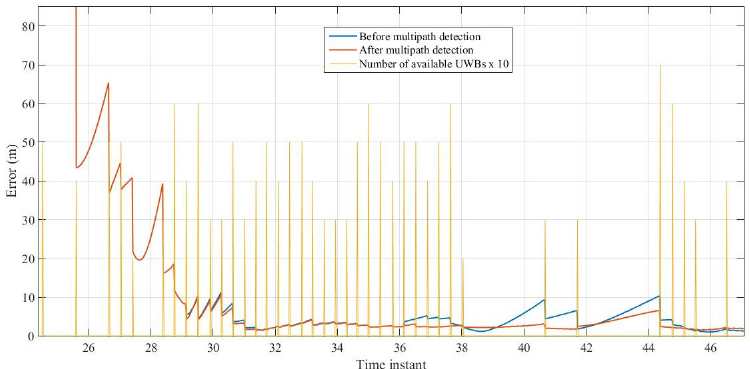
Figure 27. View1: Zoomed view of Figure